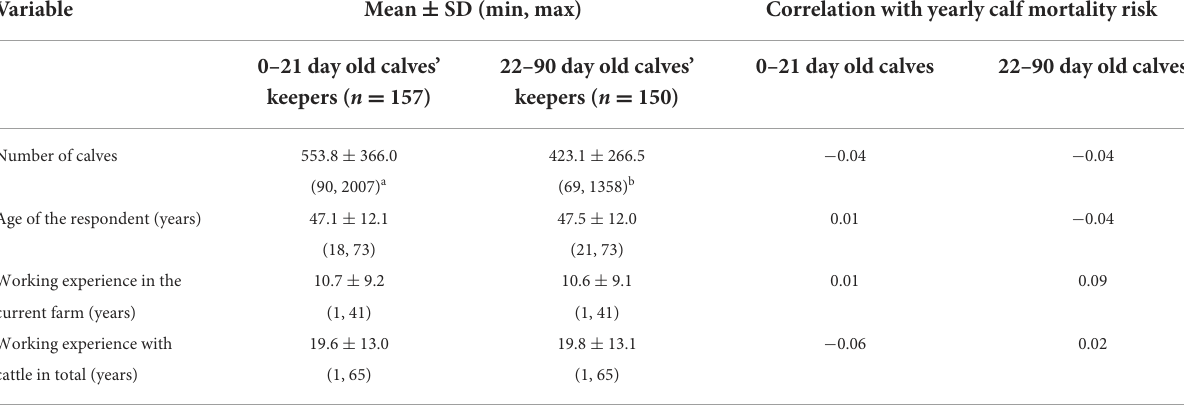
TABLE 2 Descriptive statistics of farm and respondent variables and their Spearman correlation coefficients with yearly calf mortality risk.